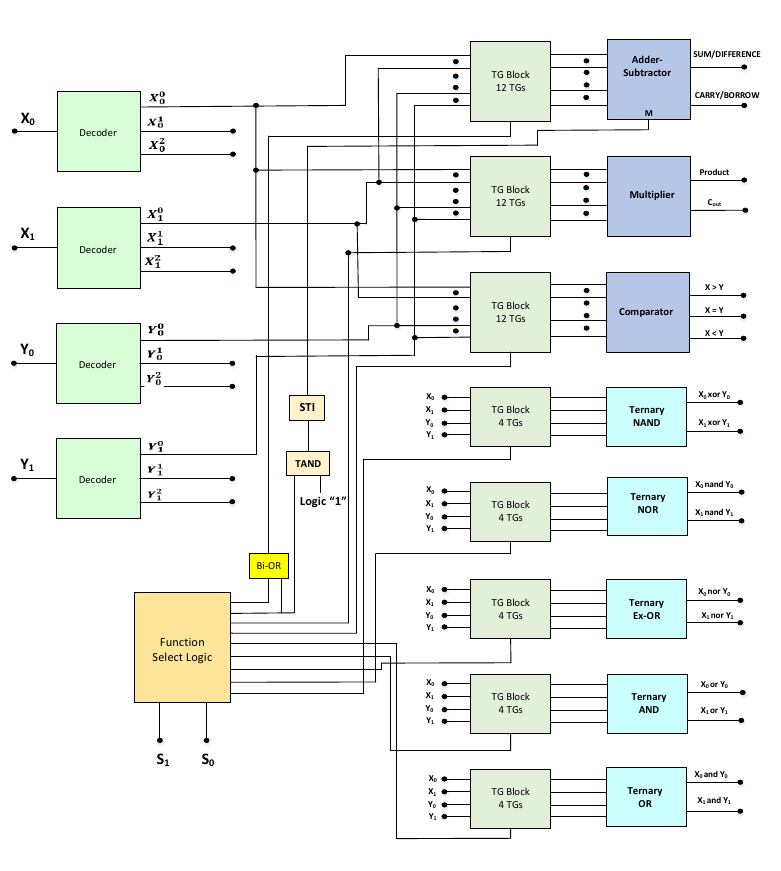
Figure 2. Proposed architecture of 2-trit ternary ALU.